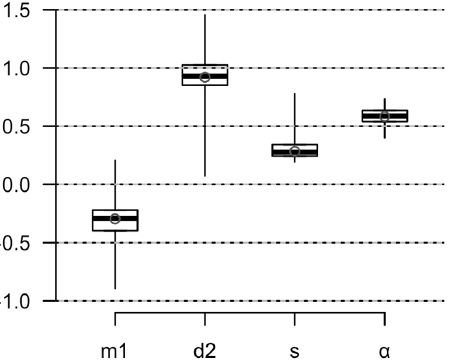
Figure 3. Quantile boxplots representing the median, inter- quartile range and 95% confidence limits of the parameters of the bimodal distribution model obtained from the Adiposity data in FH + by bootstrap re-sampling. m1 = mean of the lower mode; d2= difference between the means of the 2 modes; s = common standard deviation; a = the fraction of individuals in the higher distribution. The open circles are the estimates from the original data.